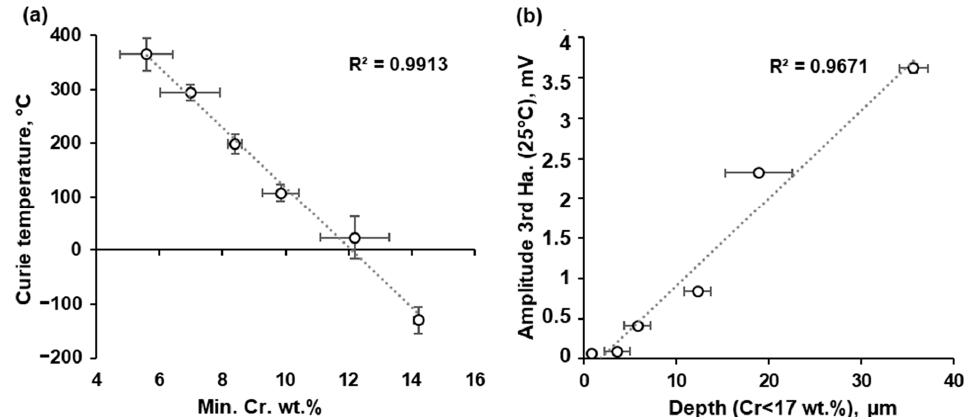
Figure 3. ( a ) Minimum Cr content vs. Curie temperature and ( b ) size of the chromium-depleted subsurface region vs amplitude of the third harmonic Reprinted with permission from ref. [18]. Copyright 2022 Taylor &